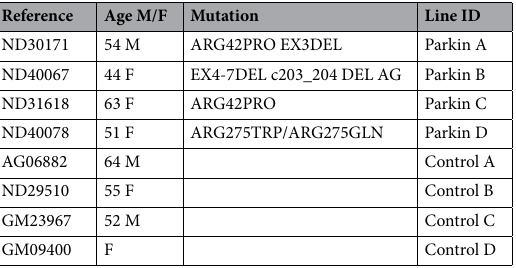
Table 1. Table giving details of the control and PRKN mutant patient lines used in this study. Further information can be found at https ://corie ll.org and https ://stemc ells.ninds genet ics.org.